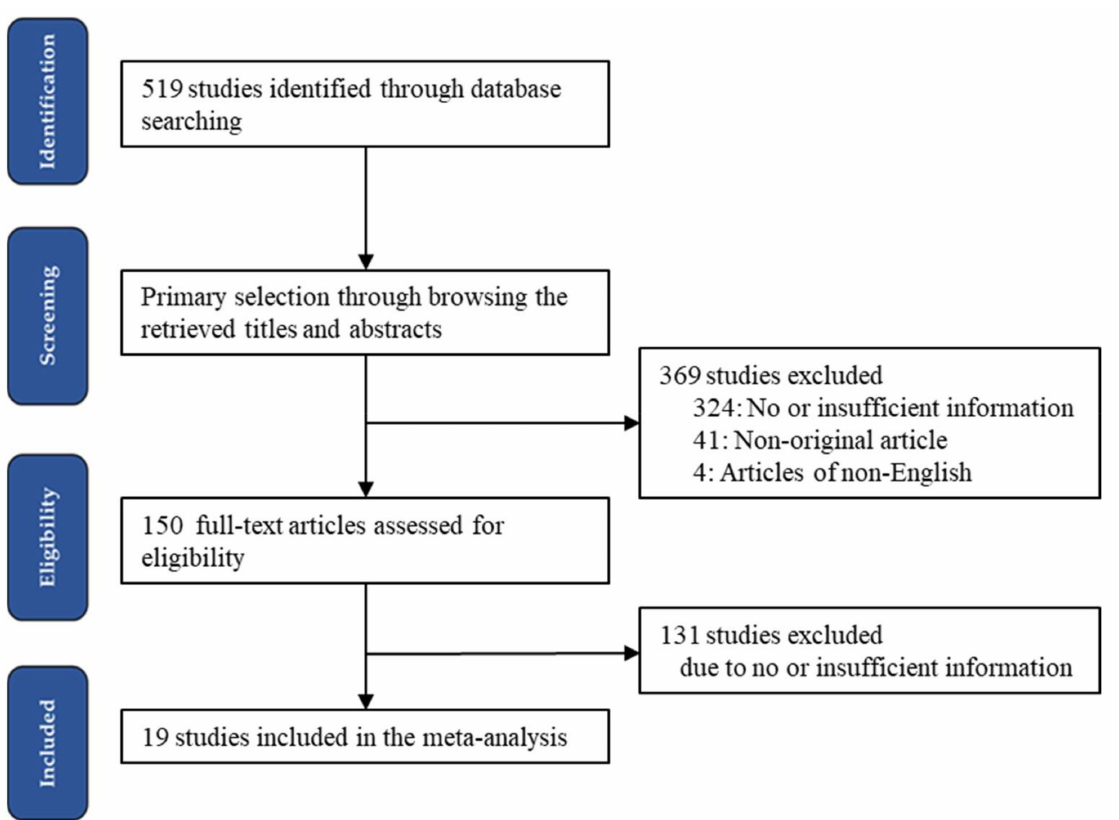
Figure 1. Flow diagram illustrating the study search and selection